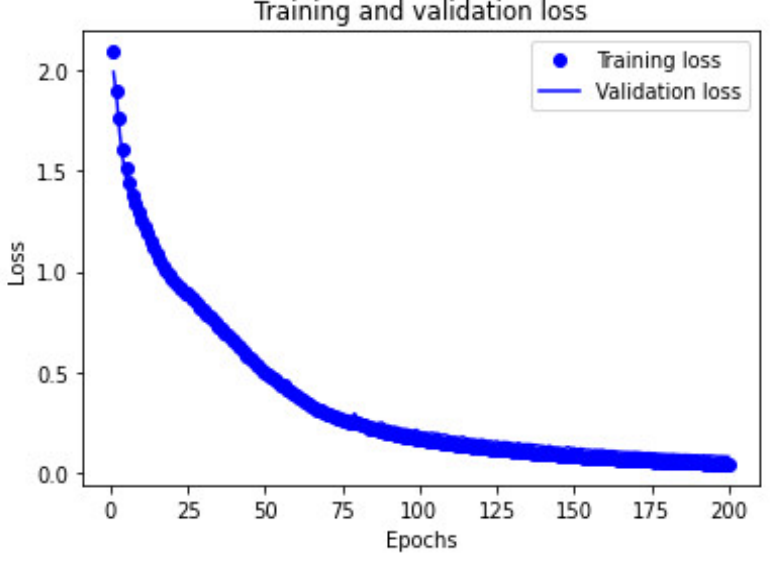
Figure 8. Training and Validation Loss of ANN.